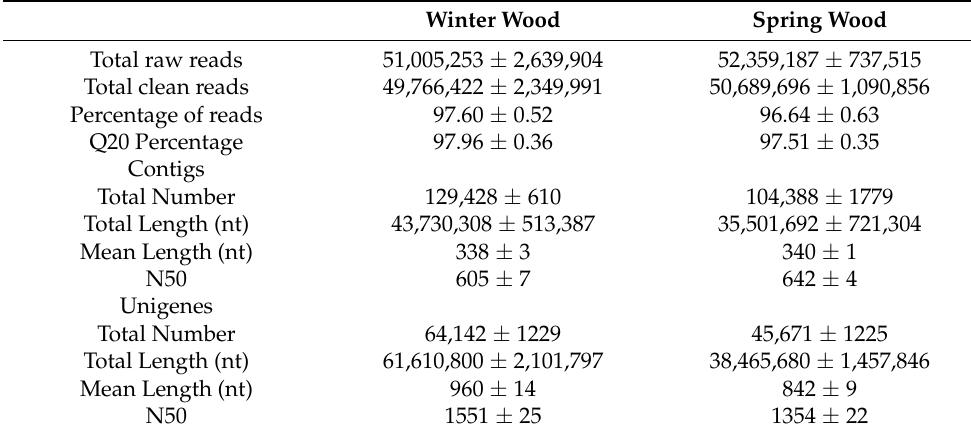
Table 1. Summary of the sequence assembly after Illumina sequencing and statistics of contigs and unigenes ( n = 3). The values are given as Mean ± SD from three